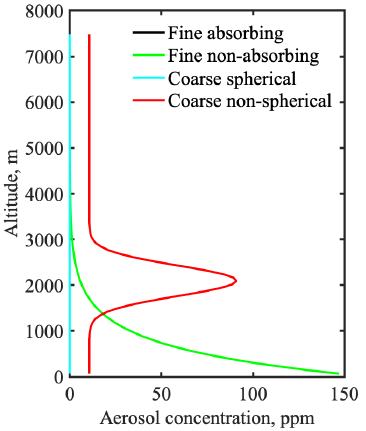
Figure 1. Aerosol vertical distribution used for the simulation in the COBALD sensitivity test.